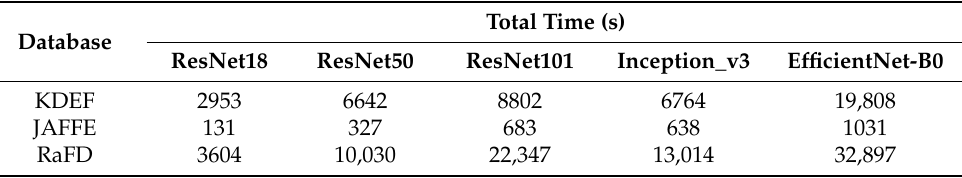
Figure 5. Classification accuracy after retraining each CNN on the corresponding database. The dashed lines depict the previous (without CNNs retraining) highest results for each database. Table 6. Total time needed (in seconds) for retraining with 80% of the files and extracting results in 20% of the files for all